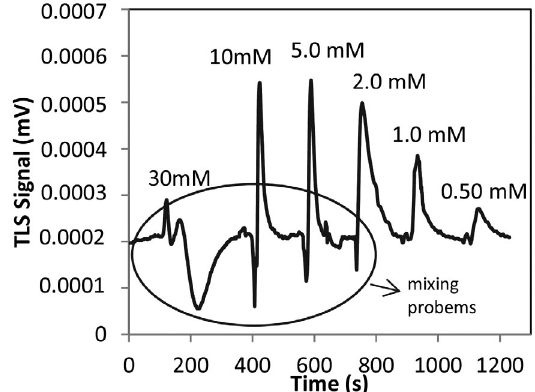
Figure 5. The shape of TLS signal peaks for different concentrations of PHN in carrier